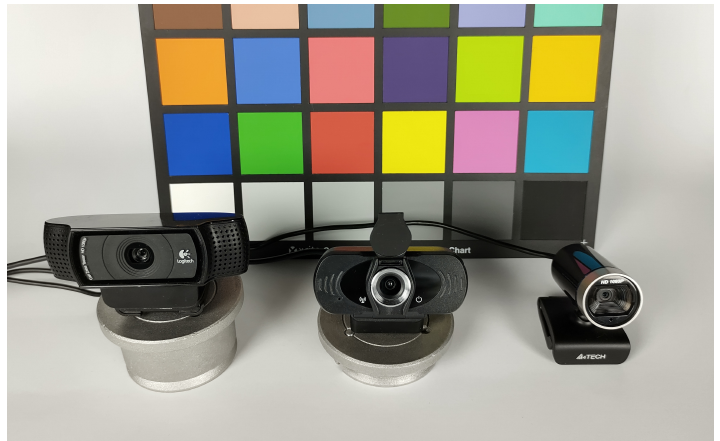
Figure 6. Cameras used in the experiment, from left to right: Logitech C920 (C AM -A), Xiaomi IMILAB CMSXJ22A (C AM -B), and A4Tech PK-910H (C AM